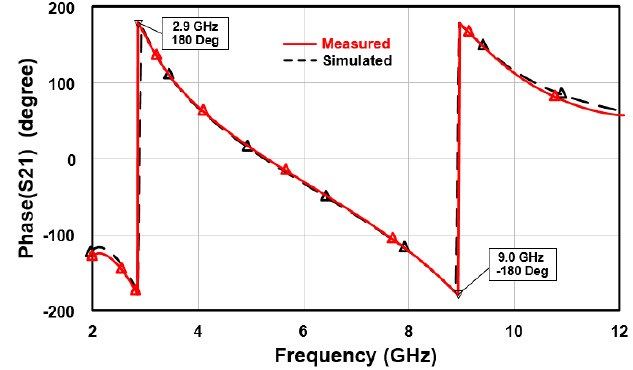
Figure 12. Measured and simulated phase response of the proposed filter.